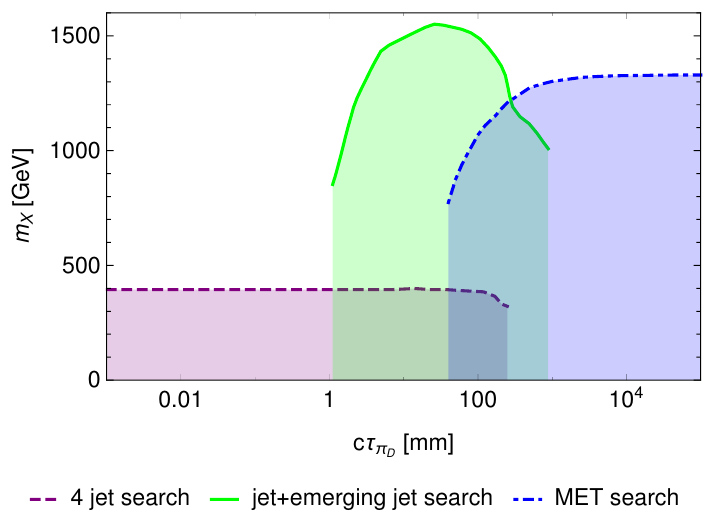
Figure 13. Constraints on the mediator mass for benchmark point C for the three searches: (i) in dashed purple: 4 jets search, (ii) in solid green: emerging jets search, (iii) in dot-dashed blue: MET search. The coloured areas are excluded by the respective